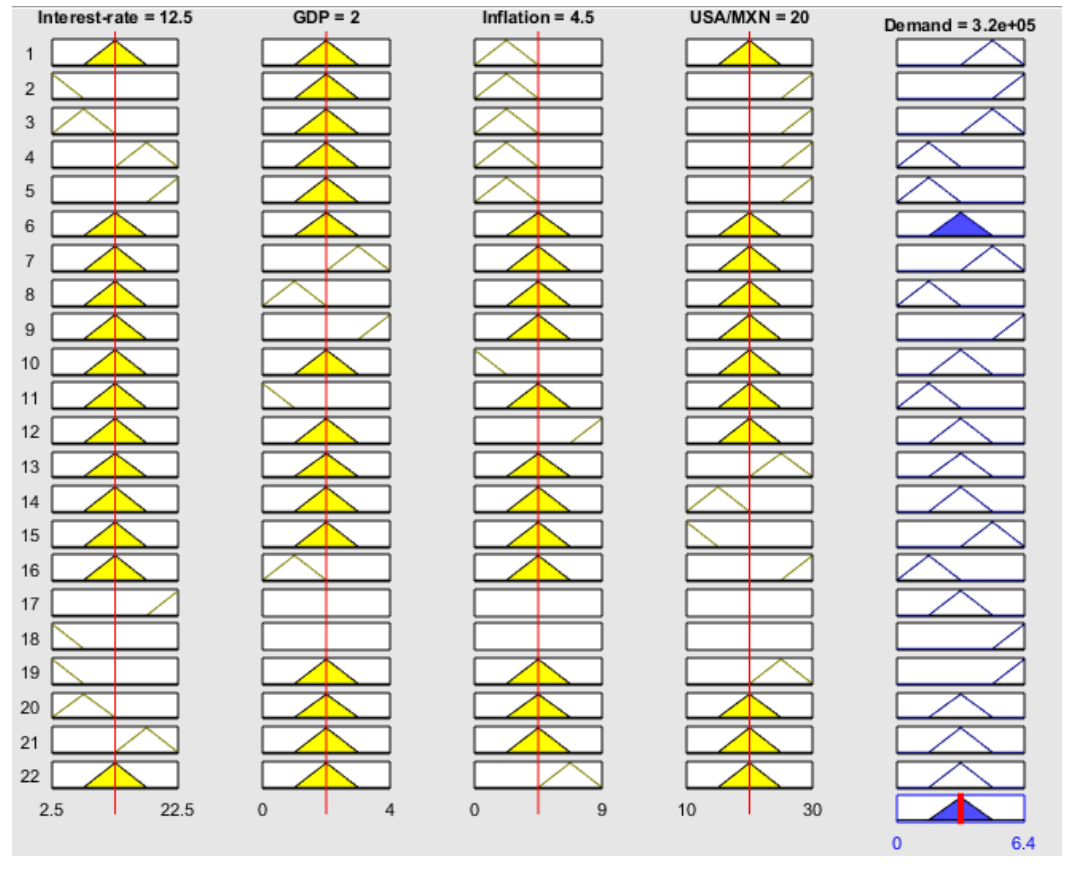
Figure 4. Fuzzy rules. Table 1. Demand